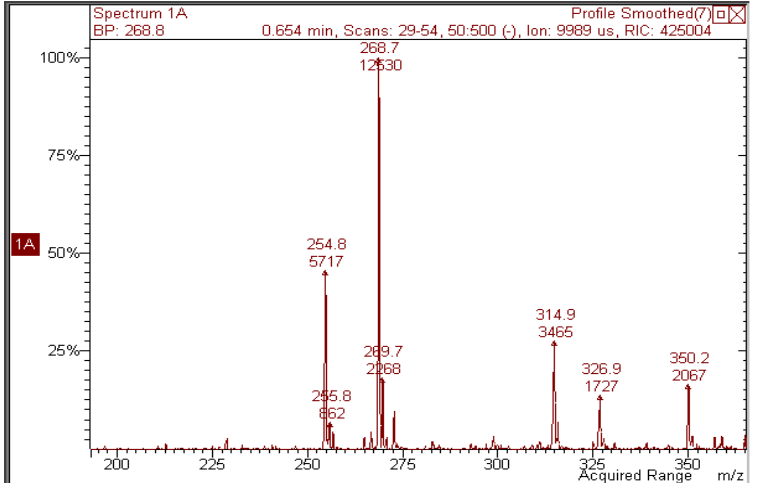
Figure 6. Negative-ion mass spectrum of a 2 × 10 − 5 M methanol solution of kaempferol irradiated with 70 J/cm 2